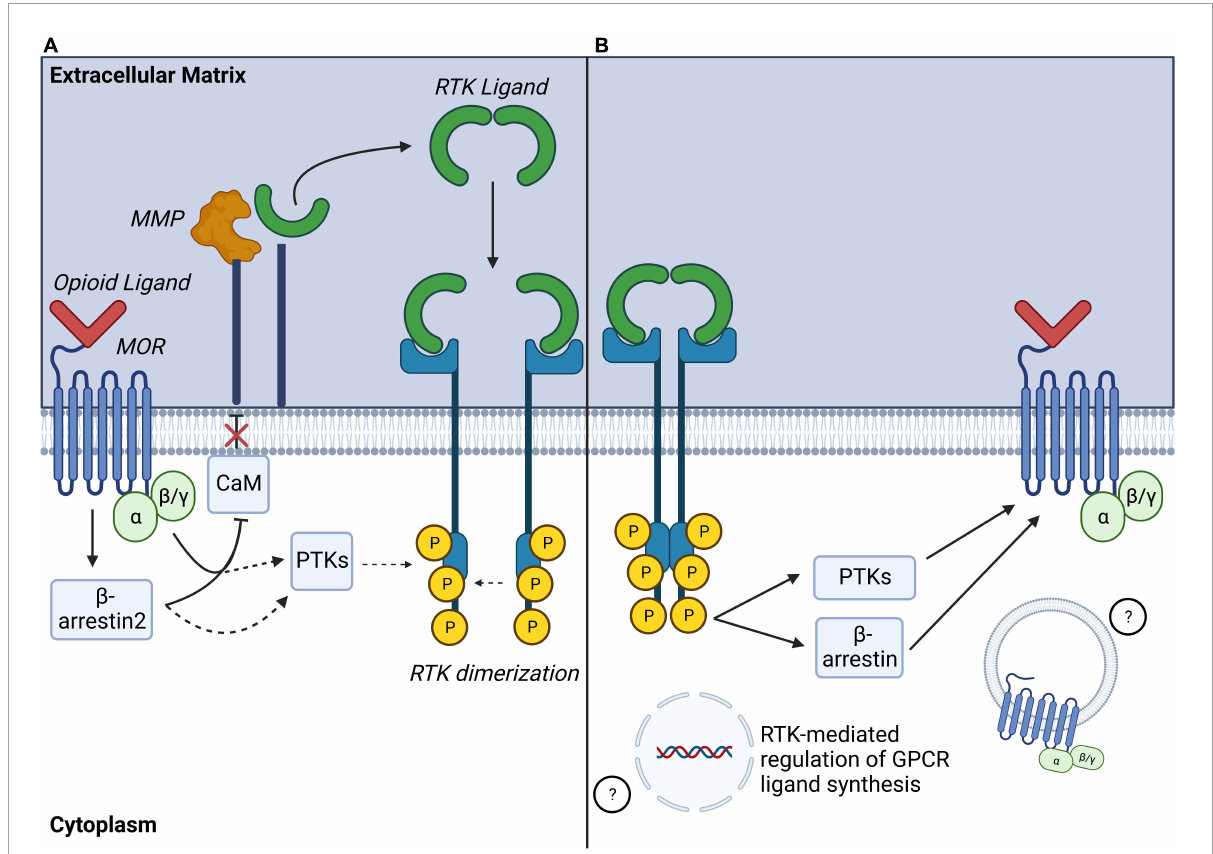
FIGURE4 Identified mechanisms of MOR-RTK crosstalk. (A) Identified mechanisms of MOR-RTK transactivation: Activated MOR can induce MMP activation via mechanisms including disinhibition Calmodulin (CaM), leading to ligand shedding and ligand-dependent RTK activation. Other ligand-independent mechanisms may involve recruitment of intracellular phosphotyrosine kinases (PTKs) to phosphorylate RTK tyrosine residues. G protein and β -arrestin2 signaling may also be involved in MOR-RTK transactivation. (B) Identified mechanisms of RTK modulation of MOR signaling: Phosphorylated RTK may modulate activation of GPCR via a recruitment of PTKs, or β -arrestins activity. RTK activation may also lead to altered GPCR ligand gene expression or MOR internalization. MOR, mu-opioid receptor; MMP, matrix metalloproteinase; RTK, receptor tyrosine kinase; GPCR, G protein coupled